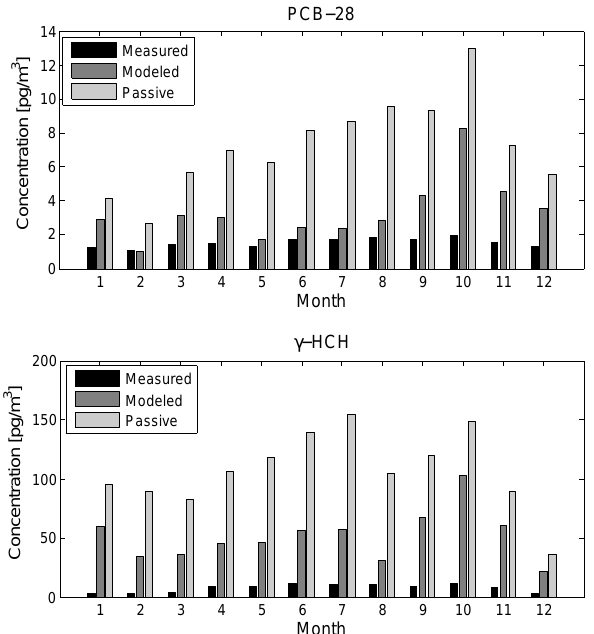
Fig. 7. Seasonal variation of the monthly mean concentrations of PCB-28 (upper panel) and γ -HCH (lower panel). Shown are the measurements (black bars) and the model results (dark grey bars) for PCB-28 and γ -HCH. Passive PCB-28 and γ -HCH tracers for which removal processes were ignored (light grey bars) are also shown.